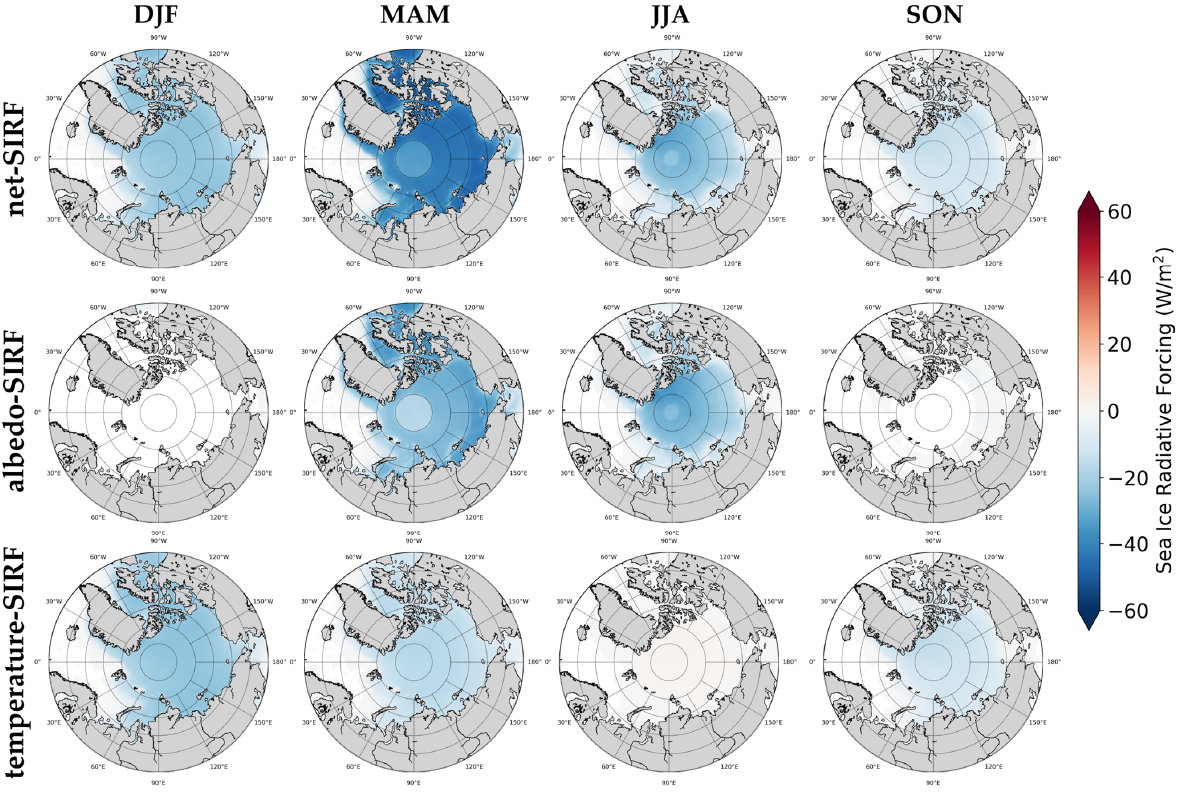
Figure 6. Seasonal SIRFs using the average of the kernels of GCMs for each factor. The horizontal line represents the period (DJF: December − January − February, MAM: March − April − May, JJA: June − July − August, SON: September − October − November), and the vertical line represents the radiative forcing for each factor (net-SIRF, albedo-SIRF, temperature-SIRF). There was a net-SIRF value of 0.41 ± 0.39 W/m 2 , albedo-SIRF value of 0.16 ± 0.26 W/m 2 , 3.1. The annual SIRF change in these sea areas was larger than that for the entire Arctic and temperature-SIRF value of 0.25 ± 0.19 W/m 2 throughout the Arctic region during the MAM period. In the net-SIRF calculation, temperature-SIRF contributed more than albedo- ure 5); however, the seasonal trend of SIRF changes differed by region. SIRF. However, this trend differed depending on the region. The albedo-SIRF changed more rapidly in the Baffin region (net-SIRF = 0.61 ± 0.37 W/m 2 , albedo-SIRF = 0.32 ± 0.29 W/m 2 , Table 3. SIRFs seasonal change according to region (W/m 2 ). temperature-SIRF = 0.30 ± 0.14 W/m 2 ), and Barents region (net-SIRF = 0.96 ± 0.66 W/m 2 , albedo-SIRF = 0.59 ± 0.41 W/m 2 , and temperature-SIRF = 0.38 ± 0.27 W/m 2 ) than other areas. The net-SIRF value of the Barents region was the largest during the entire study period. Con- versely, the smallest value was observed in the Beaufort region (net-SIRF = 0.33 ± 0.13 W/m 2 ), in which the albedo-SIRF was also the smallest (0.11 ± 0.12 W/m 2 ). Overall, the differ- ence in average albedo-SIRF (0.16 W/m 2 ) tended to be larger than that in the average temperature-SIRF (0.08 W/m 2 ) in most